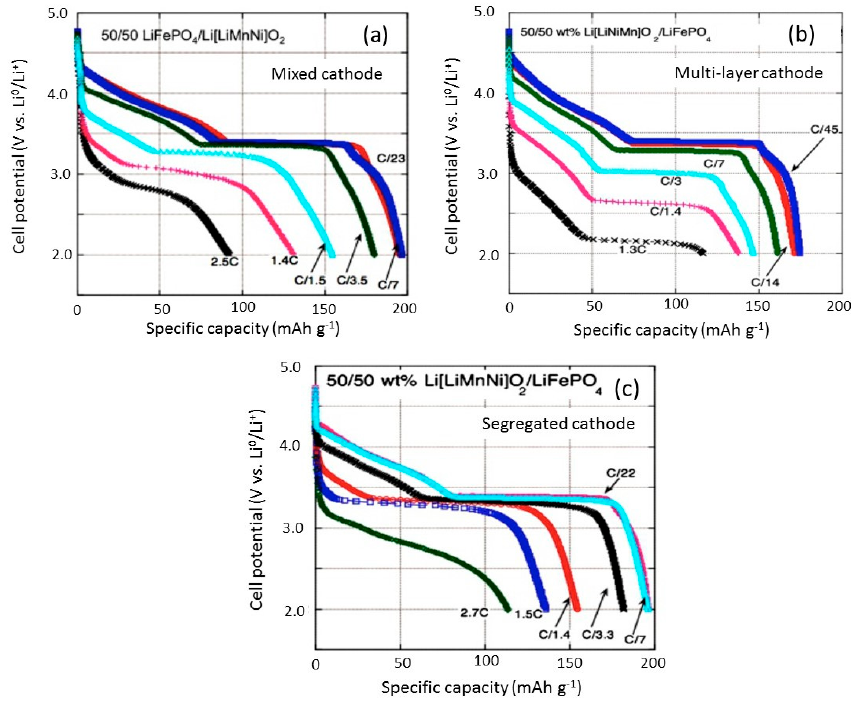
Figure 13. Discharge curves of Li[Li 0.17 Mn 0.58 Ni 0.25 ]O 2 –LFP blended cathodes in different geometries [13]. ( a ) physically mixed cathode, ( b ) multilayer cathode and ( c ) segregated